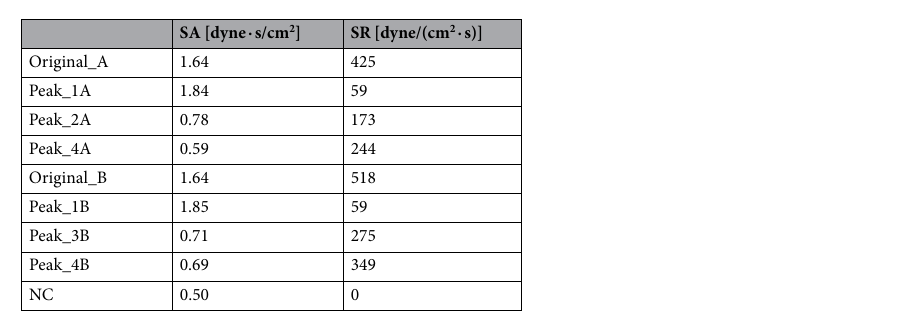
Table 2. Values of Stress Accumulation (SA) and Shear Stress Loading Rate (Stress Rate, SR) calculated for each of the test curves of our data set are compared with respect to values characteristics of the Original curves. The low-frequency curves (Peak_1A and 1B) show higher SA than Original curves but lower SR; SA progressively decreases while SR further increases in medium- (Peak_2A and 3B) and high-frequency curves (Peak_4A and 4B). The negative control (NC) curve has the lowest SA and null